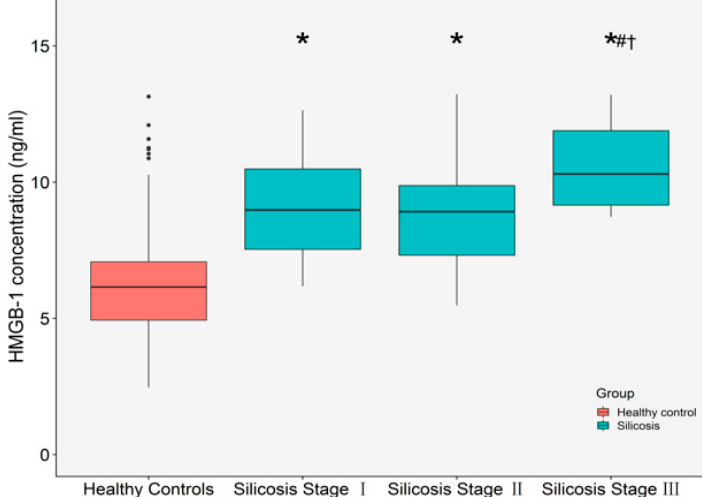
Figure 1. The distributions of plasma HMGB-1 concentrations in different group. * Compared with healthy controls, p < 0.05; # compared with stage I of silicosis, p < 0.05; † compared with stage II of silicosis, p < 0.05. The numbers of healthy controls, silicosis stage I, silicosis stage II, and silicosis stage III were 107, 42, 22 and 10, respectively.